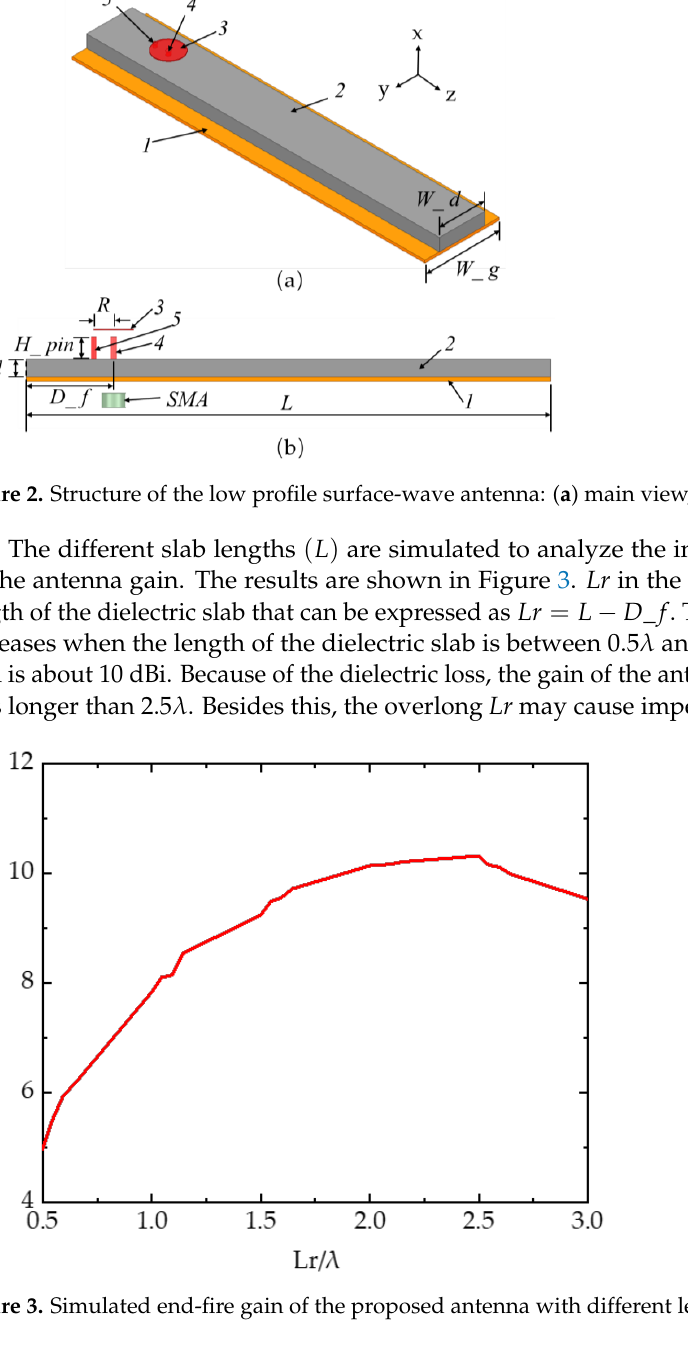
Figure 3. Simulated end-fire gain of the proposed antenna with different lengths.